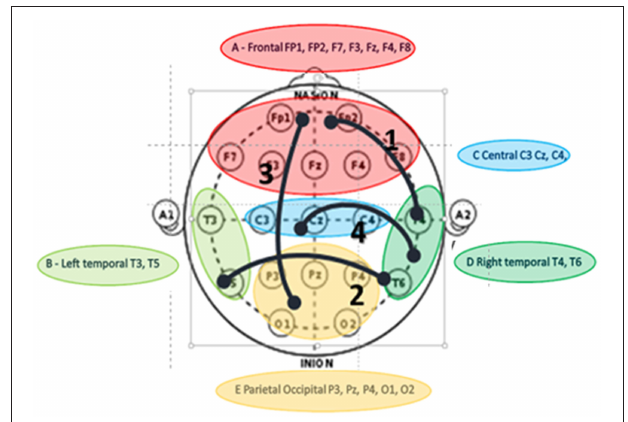
FIGURE 1 | Interregional Theta connectivity using i-coherence values to represent connections following music therapy intervention in DOC. Values of coherence not shown as diagram for illustrative purposes only. Paired electrodes groups into 5 anatomical brain regions: “1” indicates strongest regional coherence from right temporal to frontal electrodes; “2” is second coherence from right to left temporal regions; “3” is the 3rd strongest from frontal to parietal/occipital regions and “4” is the fourth level of i-coh between right temporal and central regions. There is no indication of connectivity direction, only interconnectivity (Lord,